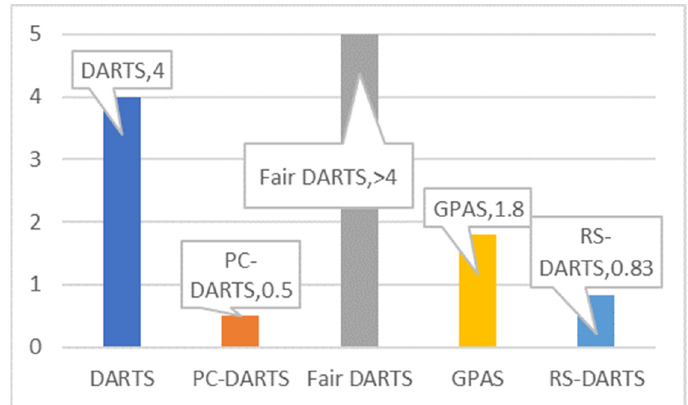
Figure 3. Searched time cost in searched phase. Table 8. Comparison of the number of model parameters during training of the optimal structural network model searched by RS-DARTS and other NAS methods (These boldface numbers represent the least number of model parameters).